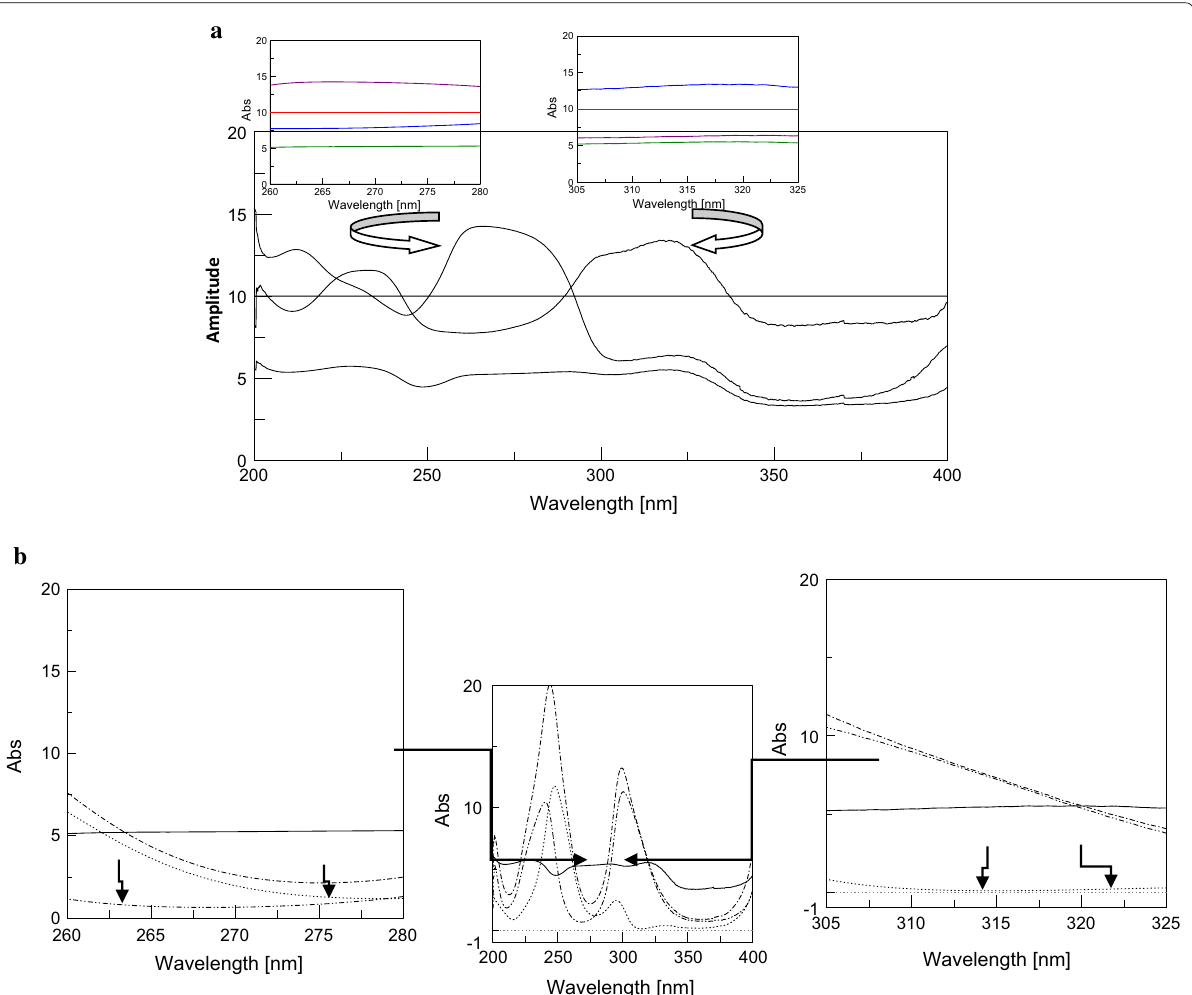
Fig. 12 a Ratio spectra of 4 binary mixtures of DRO and CAF in different concentrations using the sum of normalized spectra of DRO and CAF as double divisor showing the obtained constant regions. b Ratio spectra of binary mixture of DRO and CAF ( solid line ), PCT ( dotted line ), PAP ( dashed single dotted line ) and their quaternary mixture ( dashed double dotted line ), 5 μg/mL each using the sum of normalized spectra of CAF and PAP as double